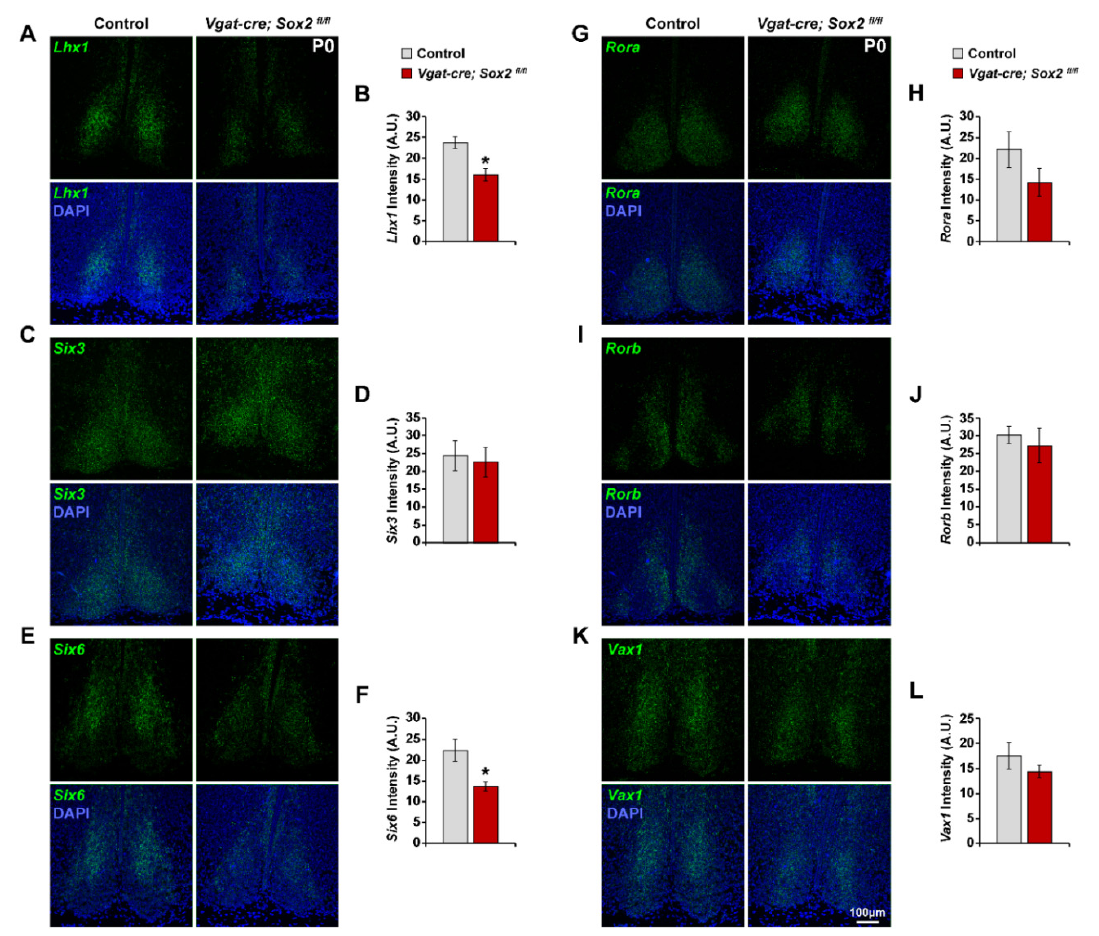
Figure 7. Loss of SOX2 disrupts Lhx1 and Six6 expression in P0 Vgat-cre;Sox2 fl/fl SCN. ( A , C , E , G , I , K ) Representative photomicrographs of ( A ) Lhx1 , ( C ) Six3 , ( E ) Six6 , ( G ) Rora , ( I ) Rorb , and ( K ) Vax1 expression (green) in the SCN of P0 control and Vgat-cre;Sox2 fl/fl mutant mice. Blue denotes DAPI. ( B , D , F , H , J , L ) The expression of ( B ) Lhx1 , ( D ) Six3 , ( F ) Six6 , ( H ) Rora , ( J ) Rorb , and ( L ) Vax1 at P0 are quantified in arbitrary units of mean grayscale intensity in the whole SCN. Values represent mean ± SEM. * p < 0.05 versus control mice, two-tailed Student’s t -test. See Table 2 for the number of animals and litters used.